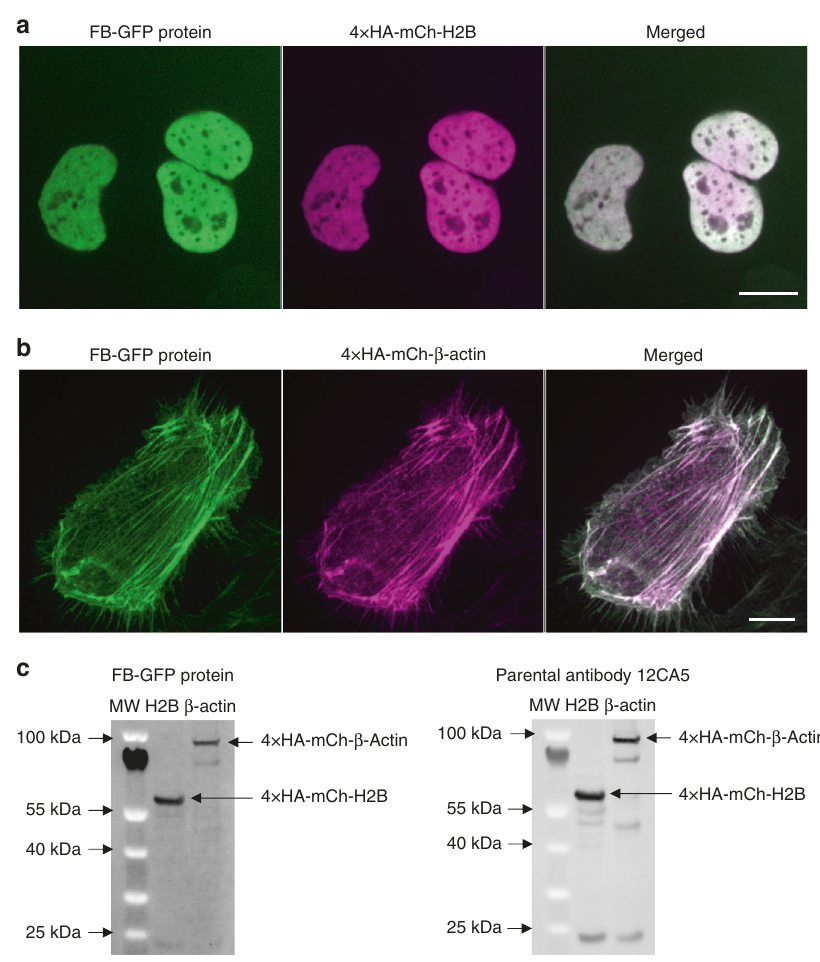
Fig. 3 Using puri fi ed recombinant frankenbody in vitro. Immunostaining in fi xed U2OS cells with puri fi ed frankenbody (FB-GFP; green) of an HA-tagged ( a ) nuclear protein, histone H2B (4 × HA-mCh-H2B; magenta; a representative cell image of n = 27 cells in one independent experiment) and ( b ) cytoplasmic protein, β -actin (4 × HA-mCh- β -actin; magenta; a representative cell image of n = 10 cells in one independent experiment). c Western blot of HA-tagged H2B and β -actin. Left: puri fi ed FB-GFP (1:2000 dilution, no secondary antibody) detected directly using GFP fl uorescence; Right: parental anti-HA antibody 12CA5 (1:2000 dilution) detected with secondary anti-mouse antibody/Alexa488 (1:5000 dilution). Scale bars, 10 µ